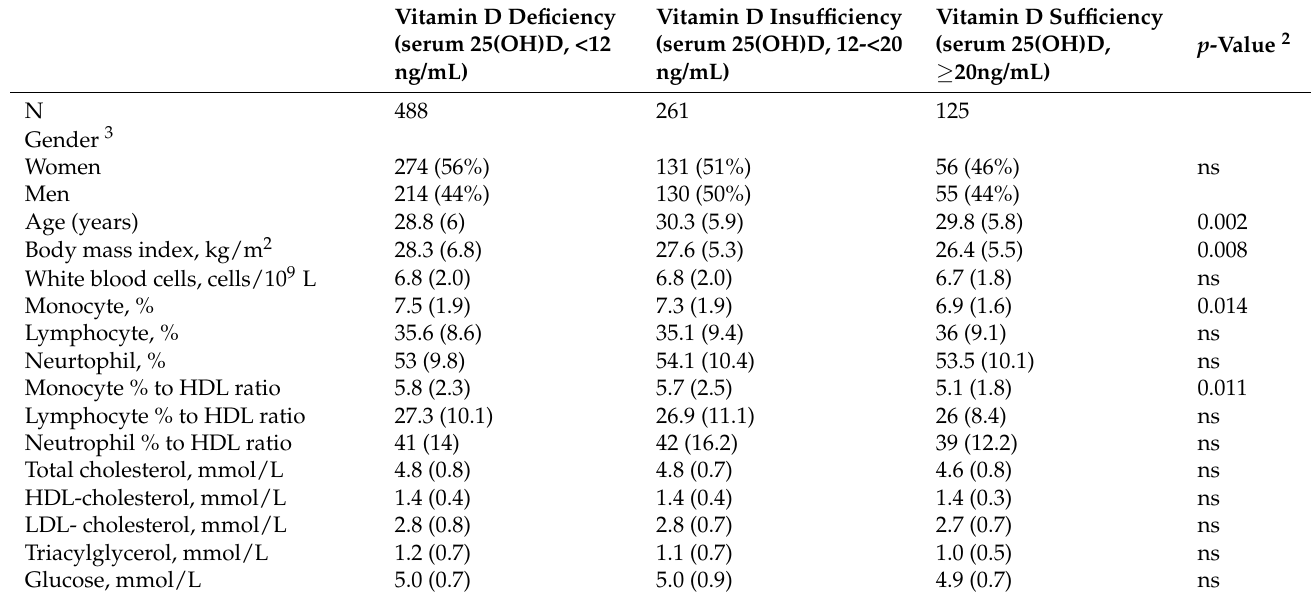
Table 1. Characteristics of the study population based on serum 25(OH)D concentrations ( n = 860) 1.